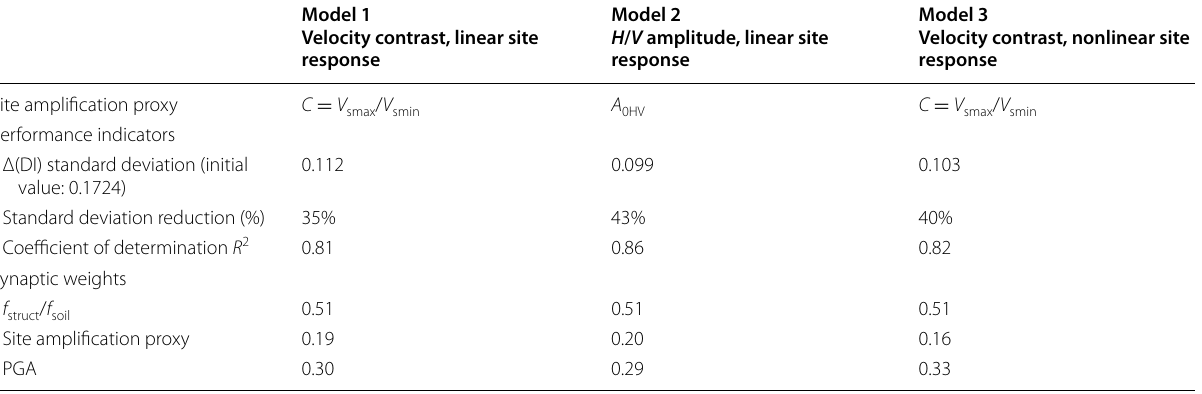
Table 1 Performance indicators (RMSE, R 2 ) and synaptic weights (lines) for the three ANN models (columns) for building